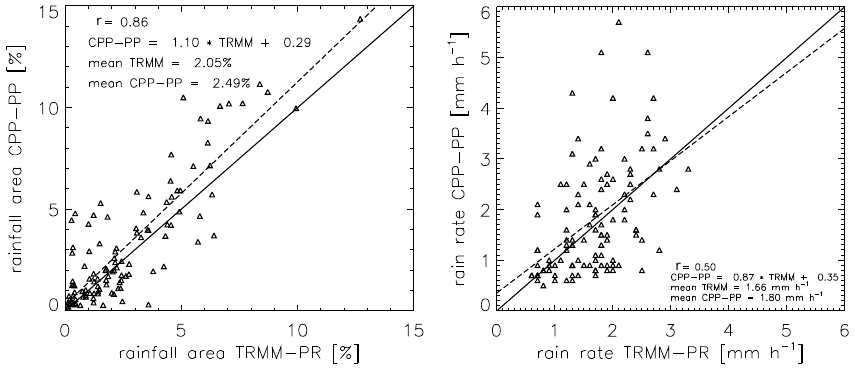
Fig. 3. (Left) detected rainfall area (in % per TRMM-PR overpass) for retrievals with R> 0.5mmh − 1 and (right) the corresponding median rain rates per overpass as observed by TRMM-PR and SEVIRI. Solid lines indicate the 1:1 relation, dashed lines denote linear regressions.